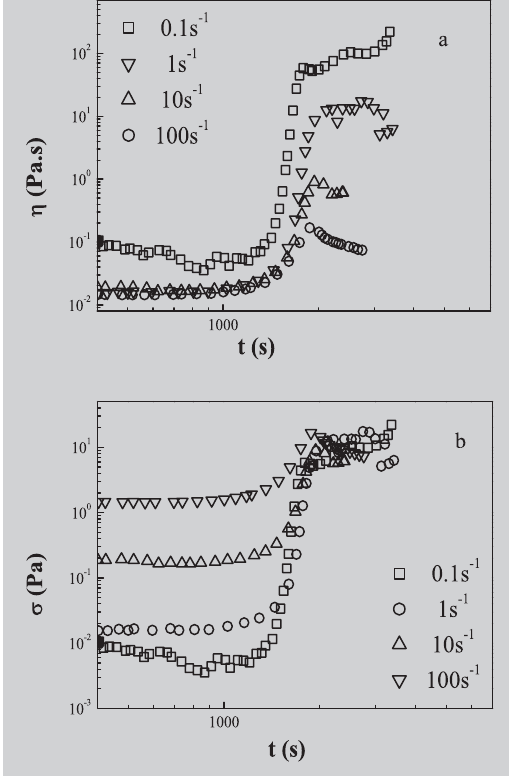
Figure 2 (left): Time dependence of the vis- cosity (a) and the stress (b) of a submicelle solution at C = 100 g/L heated at 80ºC during shear flow at differ- ent applied shear rates indi- cated in the figure. Figure 3: Viscosity as a function of time reduced by tg for a submicelle solution at C = 120 g/L heated at 80ºC during shear flow at differ- ent imposed shear stresses indicated in the